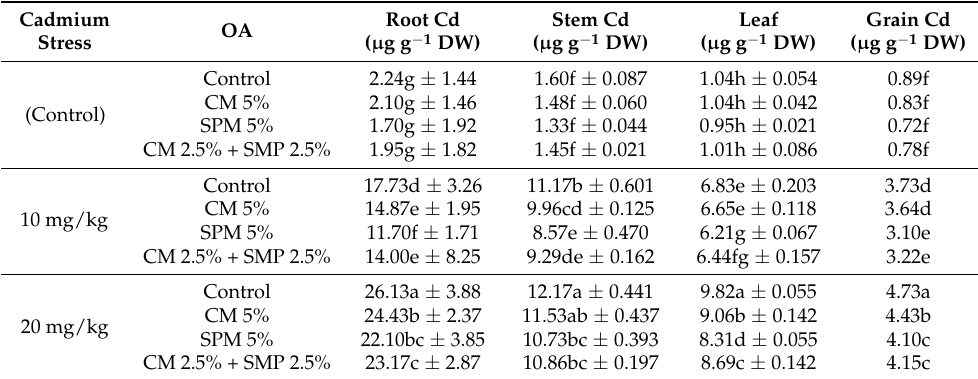
Table 3. Effect of different organic amendments on yield attributes of mash bean grown under different levels of Cd